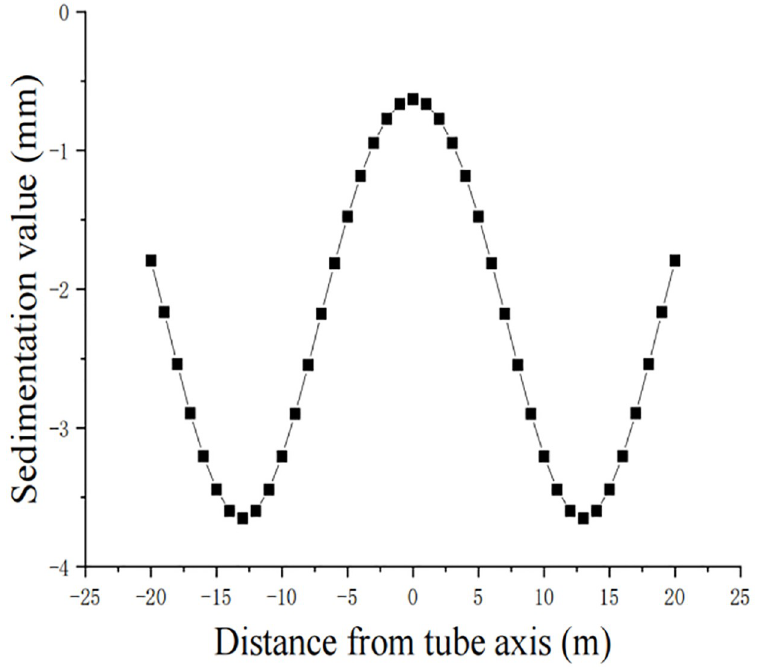
Fig 3. Peck’s formula for simulating a bilinear settlement